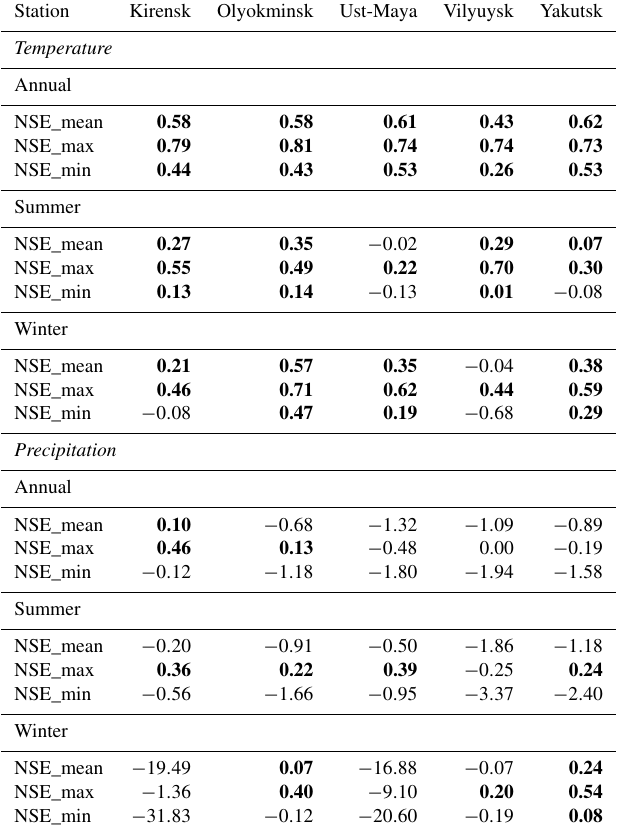
Table 1. Nash–Sutcliffe efficiency statistics of the 10 best climate simulations with respect to the CRUNCEP data for each pixel en- compassing a meteorological station with records of more than 10 years in the 1901–1921 reference period. Positive NSE in